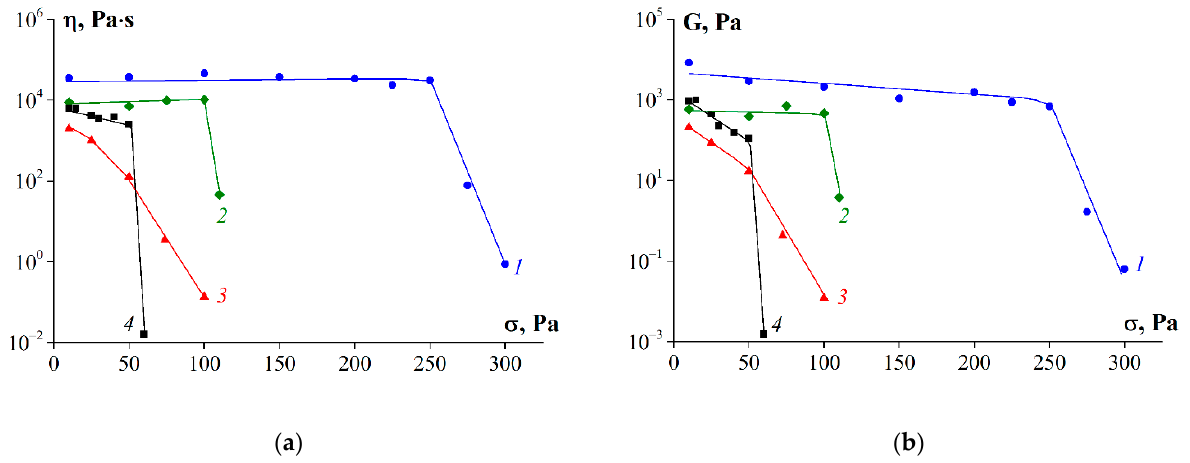
Figure 10. Dependence of ( a ) shear viscosity and ( b ) elastic modulus on shear stress at T = 6 °C, where 1—G1, 2—G2, 3—G3, 4—G 7041. Gelatin concentration was 10 wt.%.